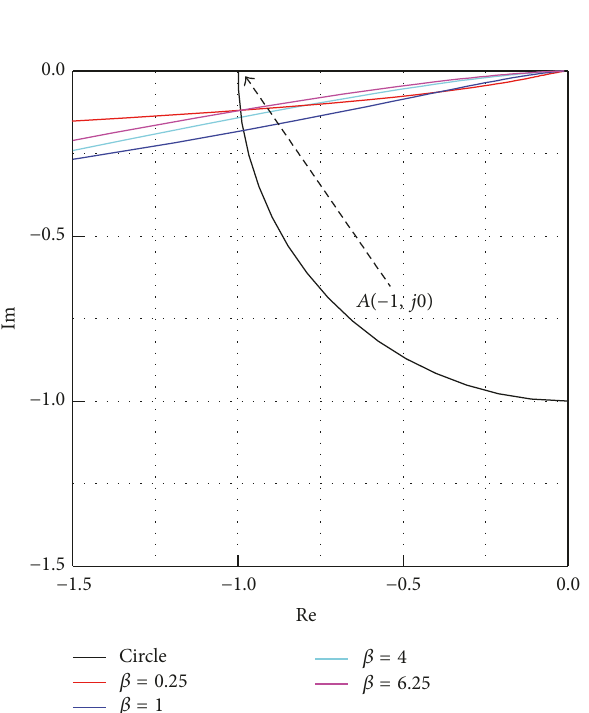
Figure 11: Zero-pole plot ( 𝛼 = 4, 𝛽 = 1 ).